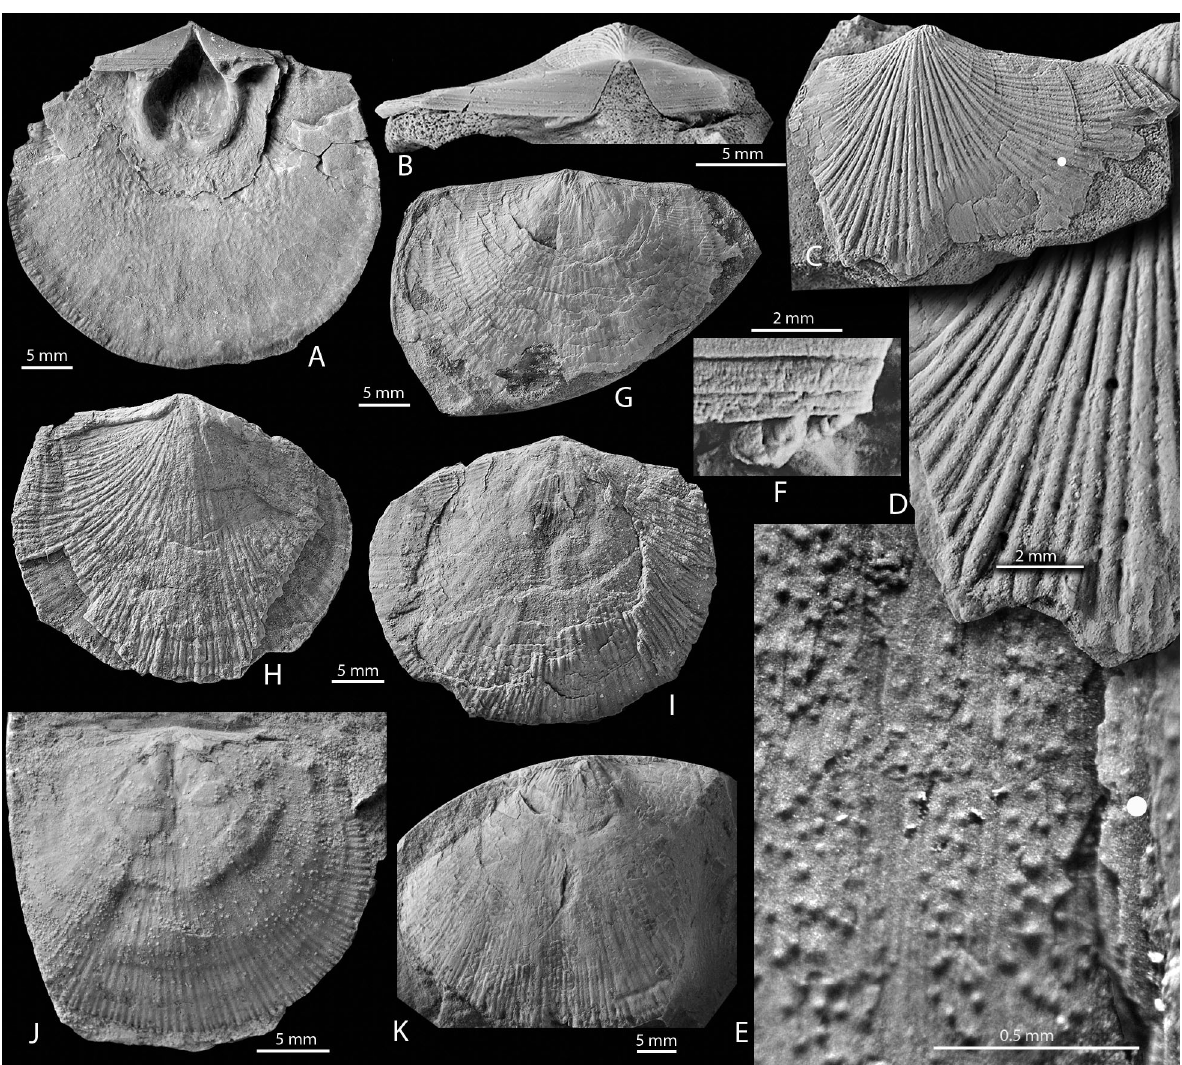
Fig. 2. A(cid:150)J . Hirnantia sagittifera (M(cid:146)Coy), western Latvia, Porkuni Stage, Kuldiga Formation. A and F, ventral valve GIT 542-1, interior and view of the teeth with the thickening; Piltene-30 drill core, 938.0 m. B (cid:150) E, incomplete ventral valve, LDM G 328-125, posterior and exterior views, views of the radial ornamentation with filae between costellae and of the broken valve surface showing the density of punctae; Piltene-30 drill core, depth 945.0 m. White spots on C and E mark one and the same place on the valve surface. G, incomplete dorsal valve LDM G 328-122; Piltene-31 drill core, depth 972.4 m. H, I, ventral and dorsal views of the shell LDM G 328-124; Piltene-32 drill core, depth 923.5 m. J, mould of dorsal interior, LDM G 295/58, Kandava drill core, depth 930.5 m. K , Hirnantia cf. sagittifera , incomplete dorsal valve GIT 542-8, split during crushing the sample; Engure drill core, depth 882.8